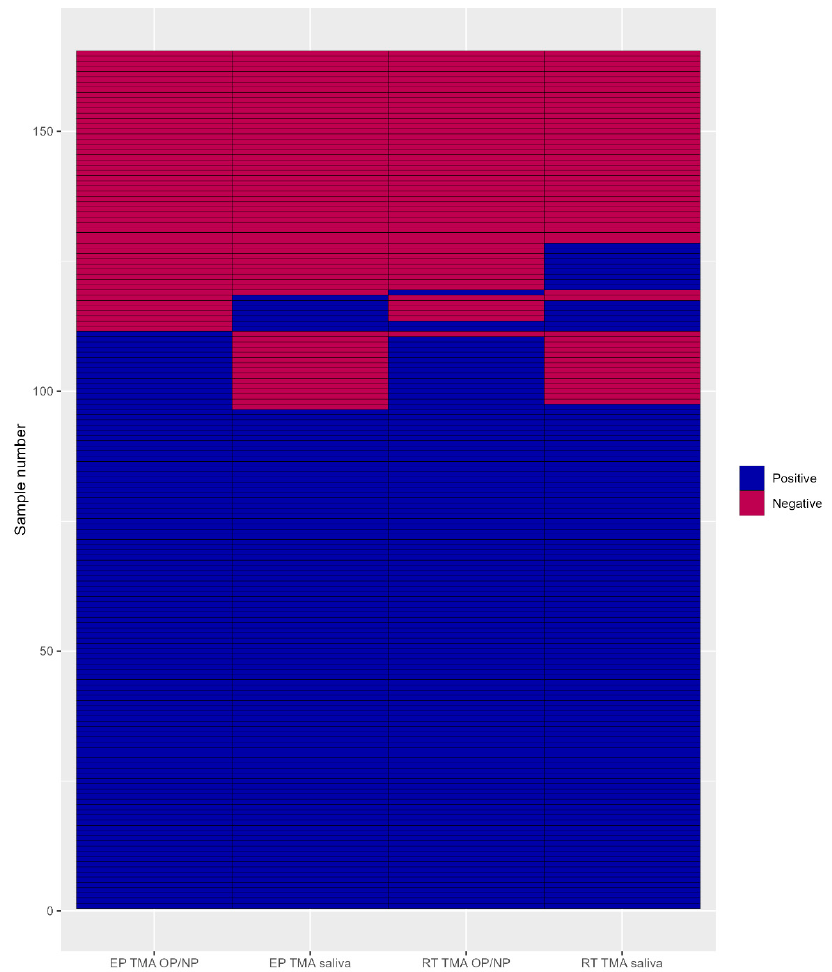
Figure 2. Test results for EP-TMA and RT-TMA ( n = 165). EP-TMA = End-Point Transcription- Mediated Amplification; RT-TMA= Real-Time Transcription-Mediated Amplification.